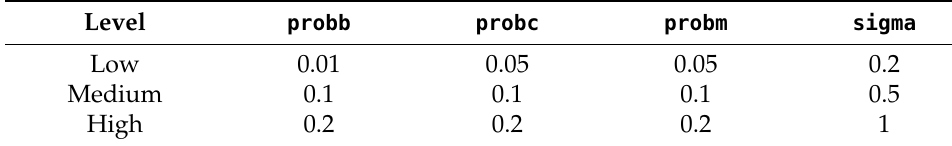
Table 2. Grouping levels and hyperparameter values for ProbSigma.